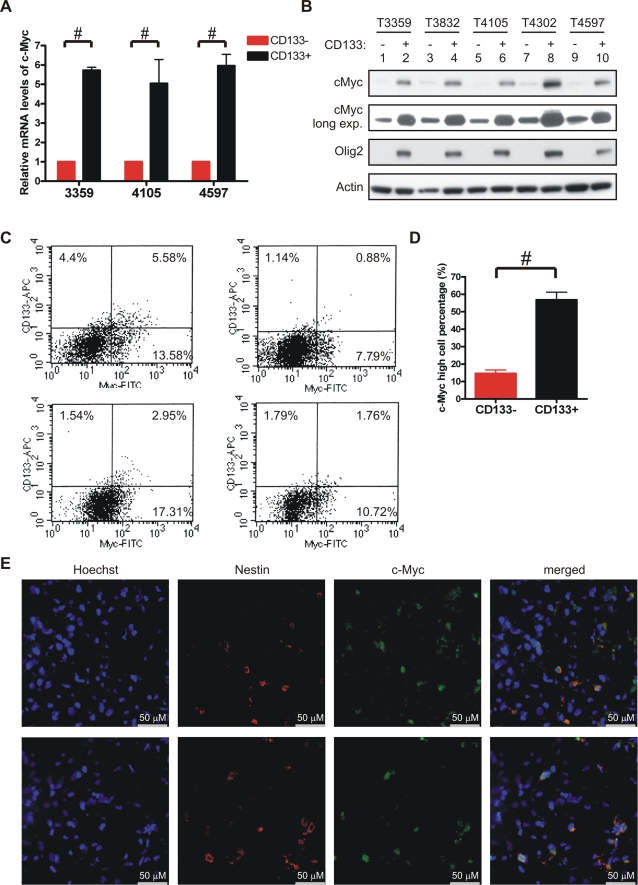
c-Myc is highly expressed in glioma cancer stem cells.(A) CD133− and CD133+ cells were isolated from glioma surgical biopsy specimens passaged short-term in immunocompromised mice and briefly cultured. Total RNA was isolated from both CD133− and CD133+ cells. cDNA was prepared by reverse transcription. Expression of c-Myc was then determined by quantitative real-time PCR and normalized to β-actin and HPRT1. Relative mRNA levels of c-Myc in CD133− cells were assigned a value of 1. Data are represented as mean±S.E.M in this and all subsequent graphs (#: p<0.001). (B) Total cellular lysates were resolved by SDS-PAGE. Protein levels of c-Myc and Olig2 were determined by immunoblotting. Actin was blotted as the loading control. (C) Glioma cells were isolated directly from human surgical biopsy specimens, fixed in 4% paraformaldehyde following dissociation, labeled with anti-CD133-APC and anti-c-Myc-FITC, and subjected to FACS analysis. (D) Percentage of cells expressing high levels of c-Myc within either the CD133− fraction or the CD133+ fraction was demonstrated (#: p<0.001). (E) Sections of freshly frozen human glioma surgical biopsy specimens were fixed and co-stained for c-Myc (green) and Nestin (red). Nuclei were counterstained with Hoechst 33342. Representative images (630×) were demonstrated.